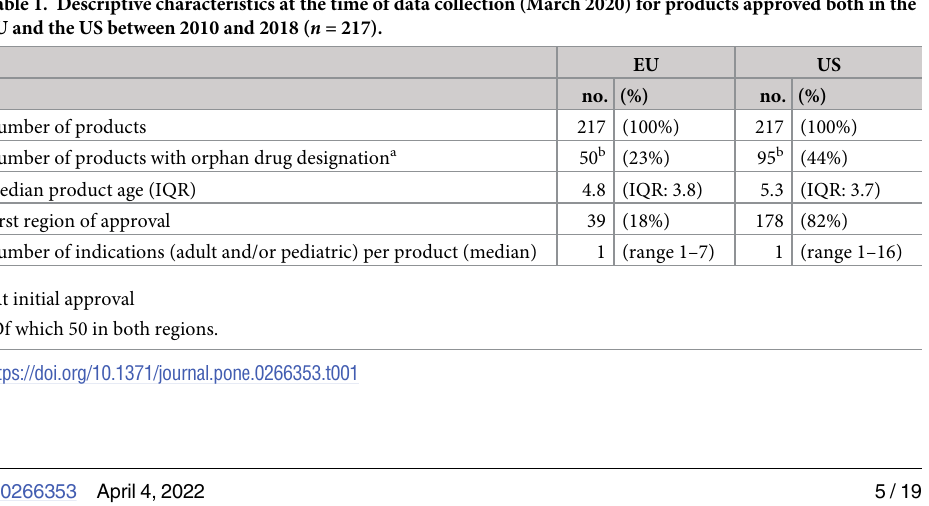
Table 1. Descriptive characteristics at the time of data collection (March 2020) for products approved both in the EU and the US between 2010 and 2018 ( n = 217).